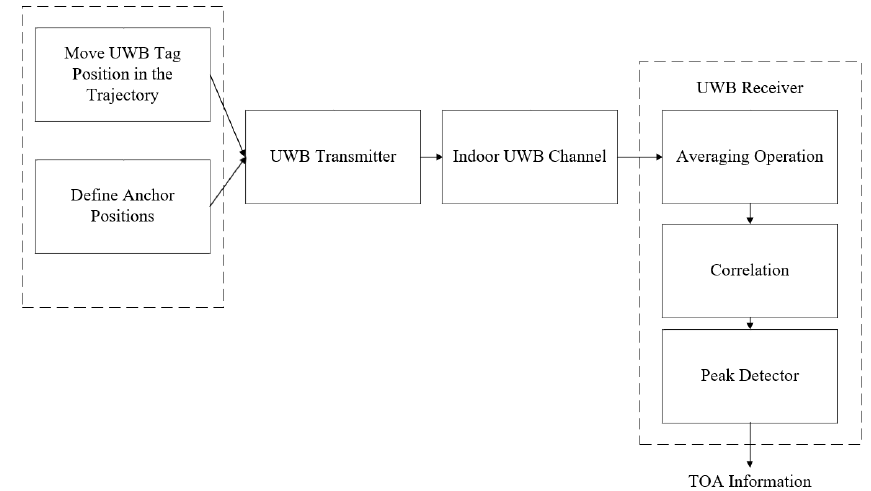
Figure 5. Block diagram of overall UWB simulation